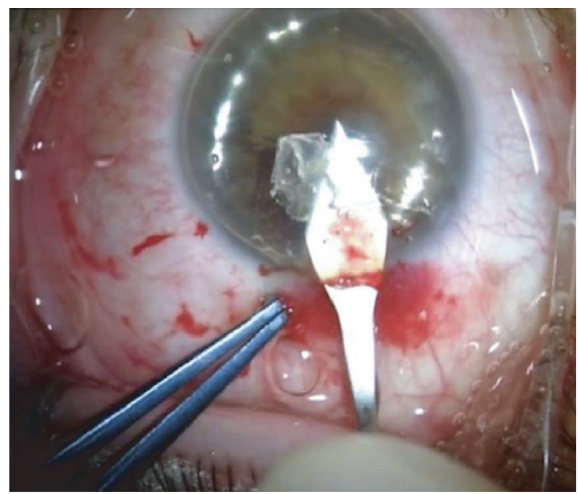
Figure 4: Main incision under